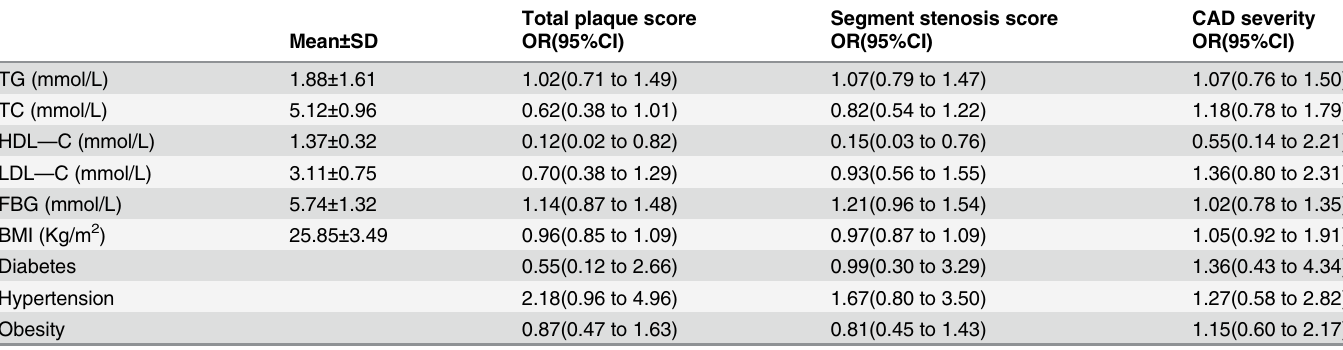
Table 3. The results of logistic regression analysis of lipid predictor.